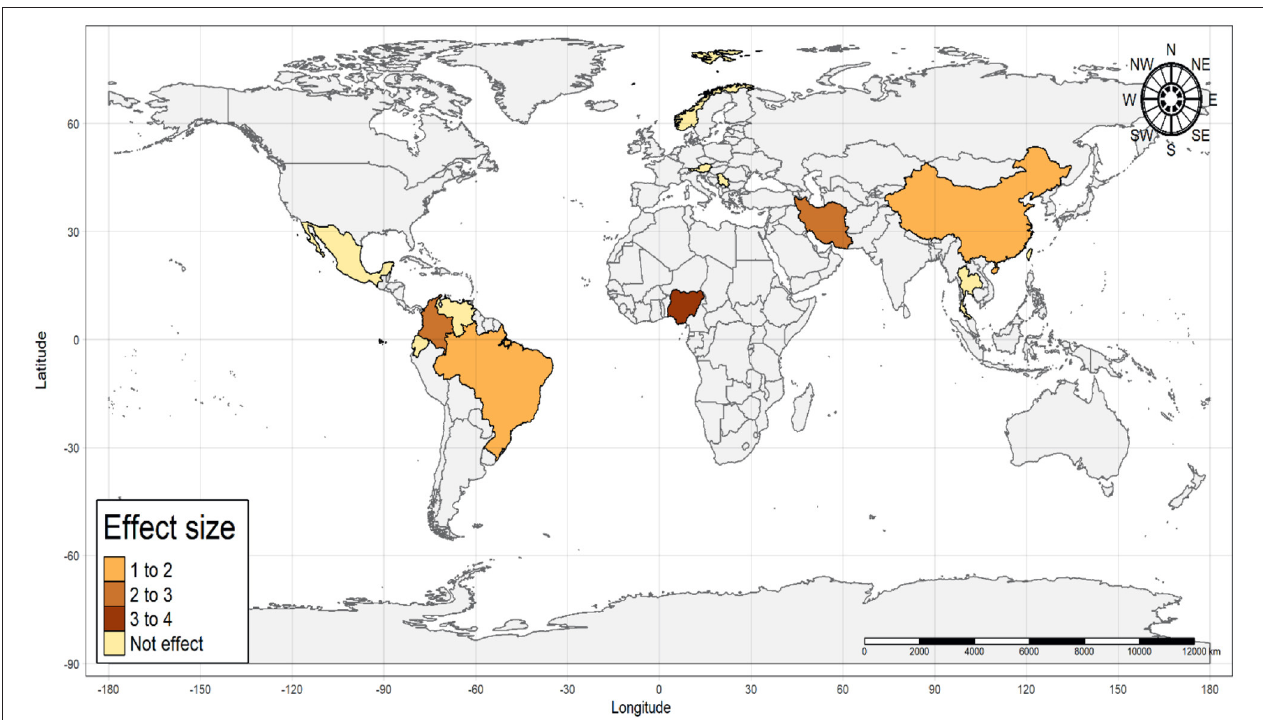
FIGURE 8 | Illustrative map of effect size from studies on the frequency of anti- Toxocara spp. antibodies in under-18 and adults, according to selected articles used in the meta-analysis from 2009 to 2021.